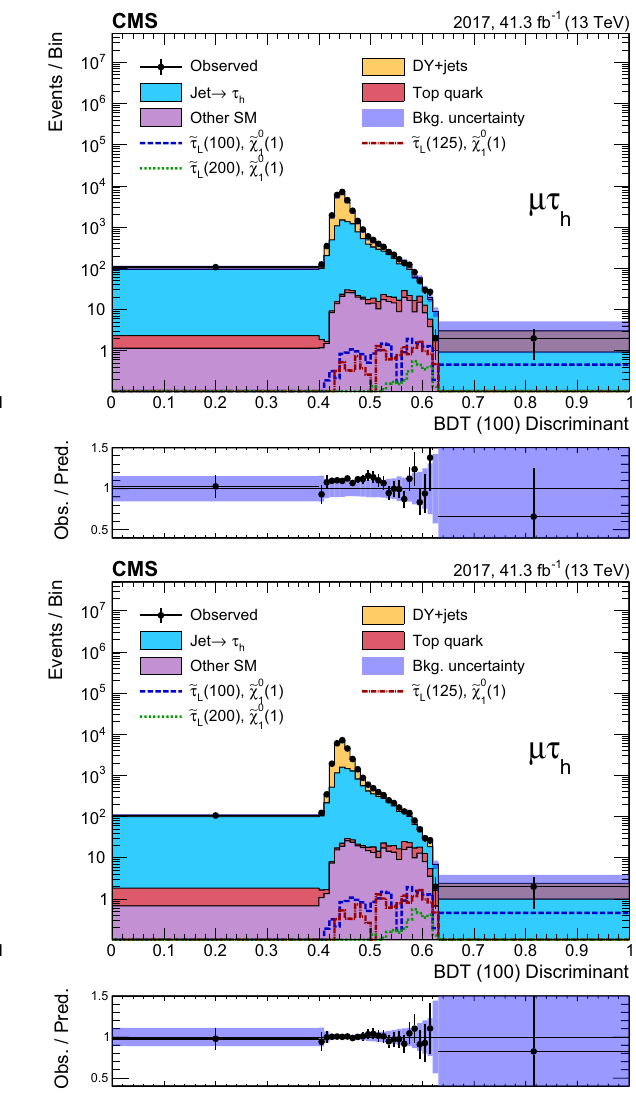
a maximum-likelihood fit to the data. Predicted signal yields are also shown for benchmark models of (cid:2) τ L pair production with m ( (cid:2) τ L ) = 100, final state for h ) = 125, and 200GeV and m ( (cid:2) χ 0 1